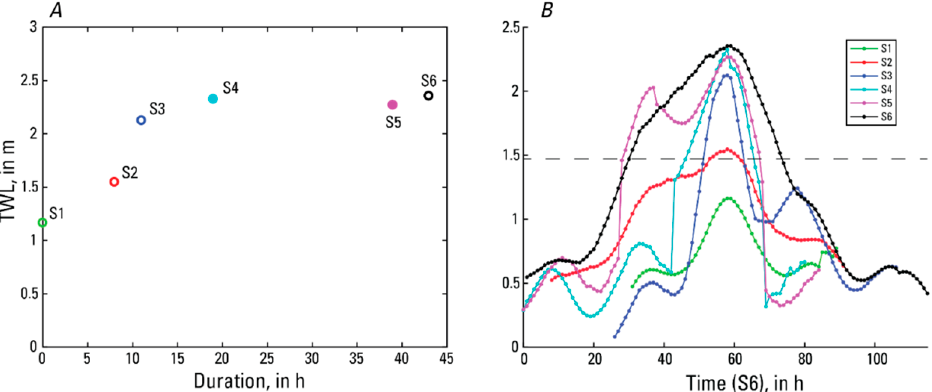
Figure 5. ( A ) Scatter of Total Water Level (TWL) versus duration (hours of TWL above dune toe threshold) for the 6 synthetic storms (S1–S6; open circles represent scenarios from [34], and closed circles from [21]). ( B ) TWL time series of each synthetic storm scenario aligned so that peak TWL coincides with S6 peak TWL; dashed line indicates the 1.47 m dune toe elevation threshold. Storm 1 (S1), represented a short-lived, low magnitude (maximum TWL = 1.16 m) storm event that did not reach above the dune toe threshold; storm 2 (S2) had slightly higher maximum TWL (1.54